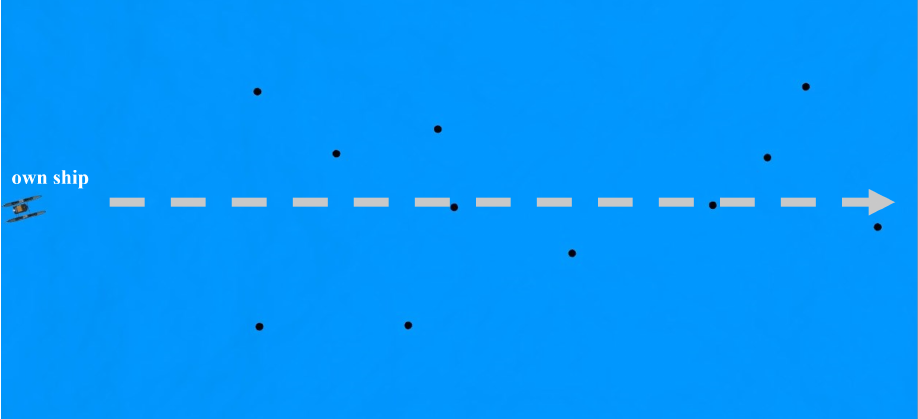
Figure 10. Scenario with multiple fixed